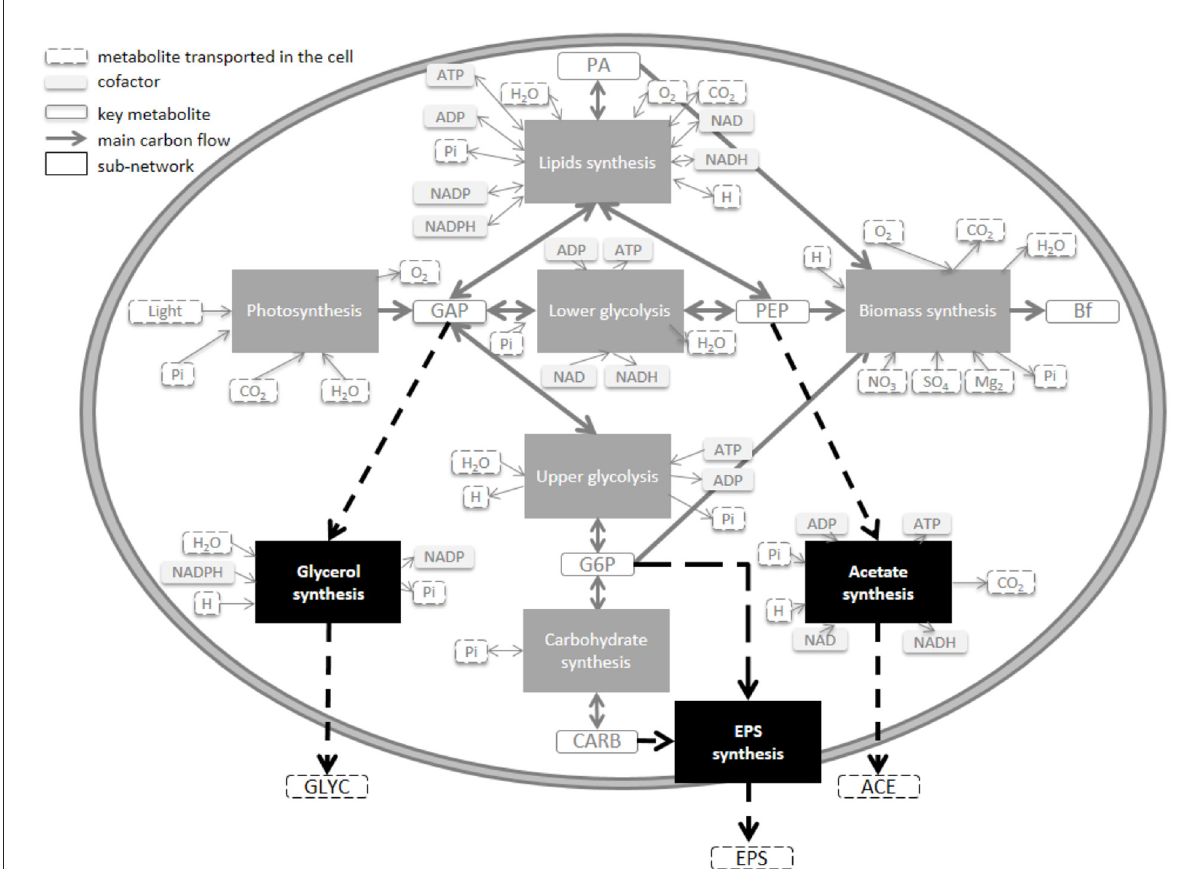
FIGURE1 Model of the central carbon metabolic network of a unicellular photoautrotophic microalgae including different carbon excretion extensions. Three excreted molecules (EPS, ACE, and GLYC) were tested at four different loci of the metabolism (CARB, G6P, PEP, and